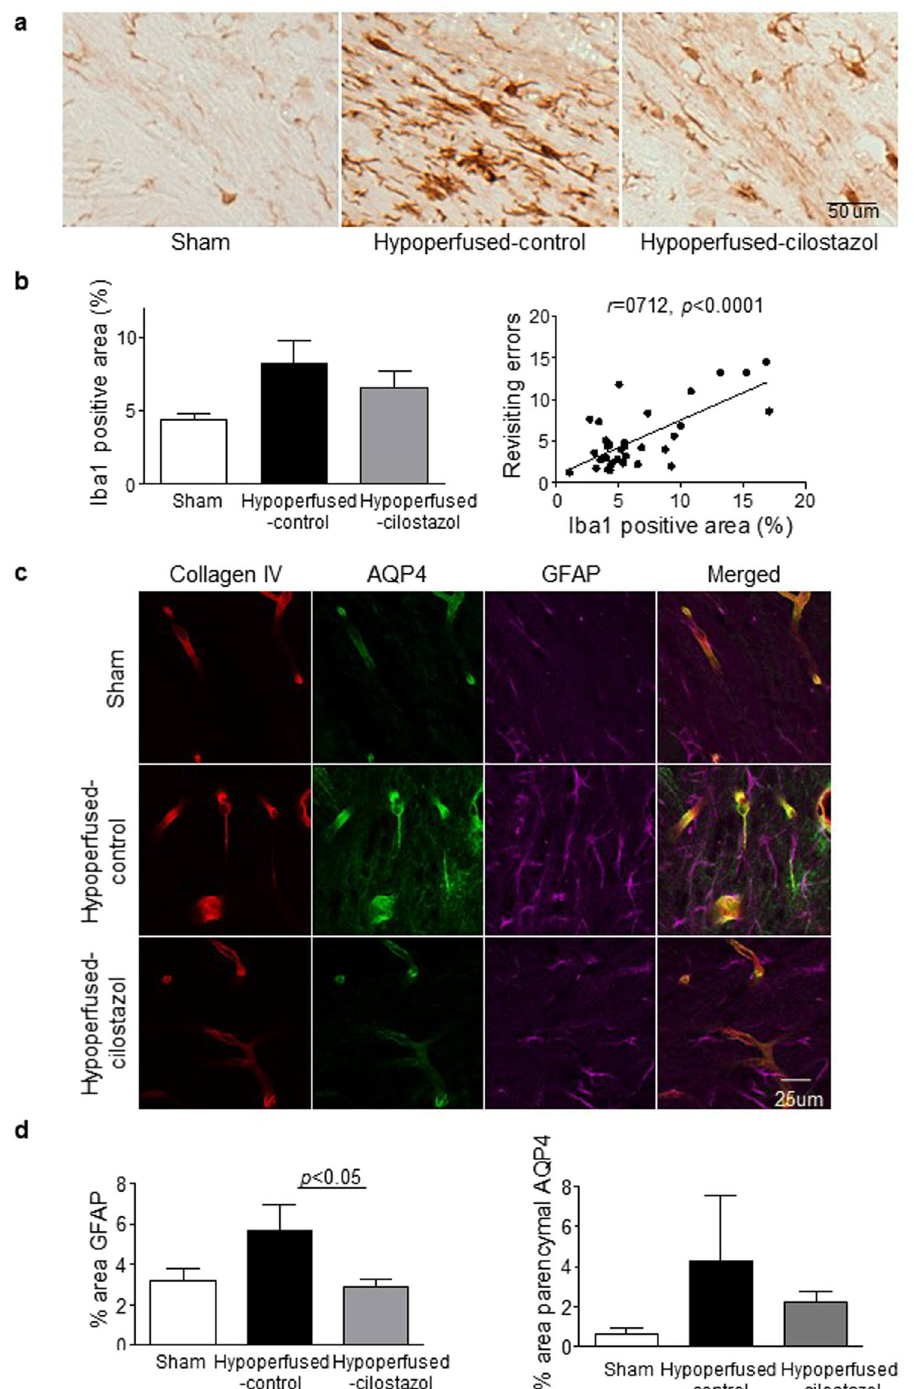
Figure 3. Cilostazol reduced the extent of gliosis. ( a ) Representative images of Iba1 staining in the corpus callosum. ( b ) There was a trend towards an increase in Iba1 stained micoglia that was reduced with cilostazol after hypoperfusion. There was a robust association between microgliosis and the number of revisiting errors (Pearson r = 0.712, p < 0.0001). ( c ) Representative images of immunofluorescence for Collagen IV, AQP4 and GFAP in the corpus callosum. ( d ) There was an increase in the area of GFAP positive astroglia in the hypoperfused-control mice. There was a significant reduction with cilostazol treatment as compared to control hypoperfused. Astrocyte-endfoot displacement tended to be observed in the hypoperfused-control mice and less in the cilostazol treated mice. Data represents mean ± SEM. * p < 0.05, Hypoperfused-control vs